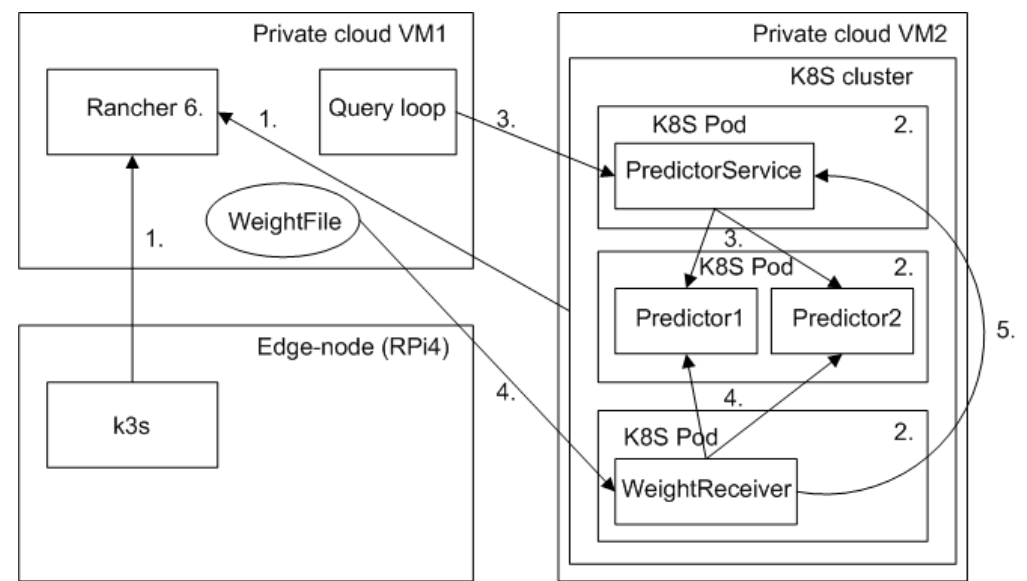
Figure A3. Architecture design for multi-threaded predictors in a K8S-Pod.